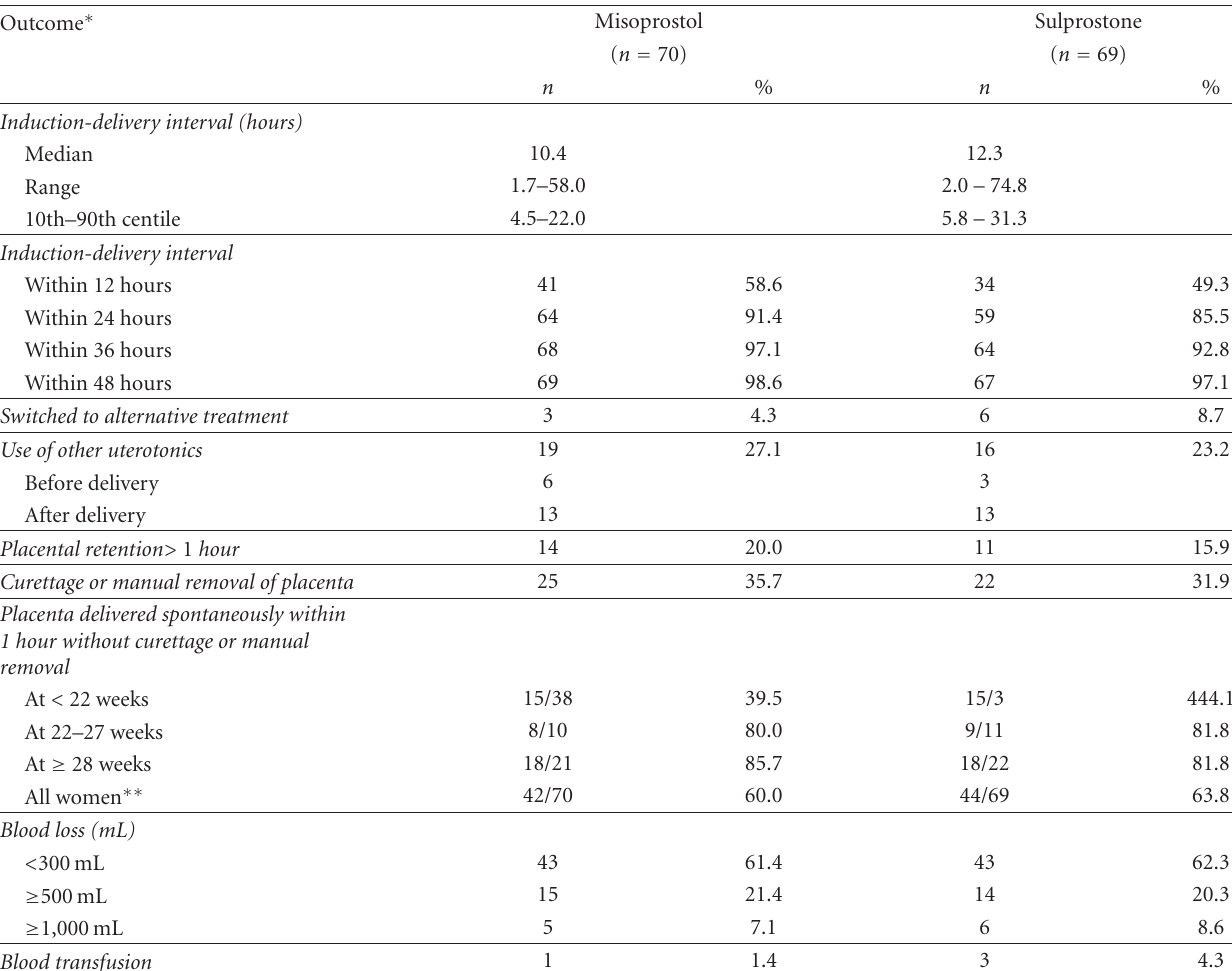
Table 2: Labor and delivery